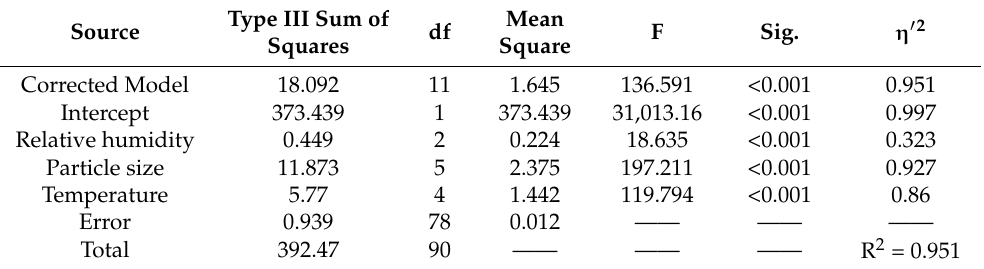
Figure 7. ( a ) Variation in deposition rates with ambient relative humidity at 20 ◦ C. ( b ) Variation in deposition rates with ambient relative humidity at 30 ◦ C. ( c ) Variation in deposition rates with ambient relative humidity at 40 ◦ C. Table 3. Results of unrepeated three-way analysis of variance ( α =